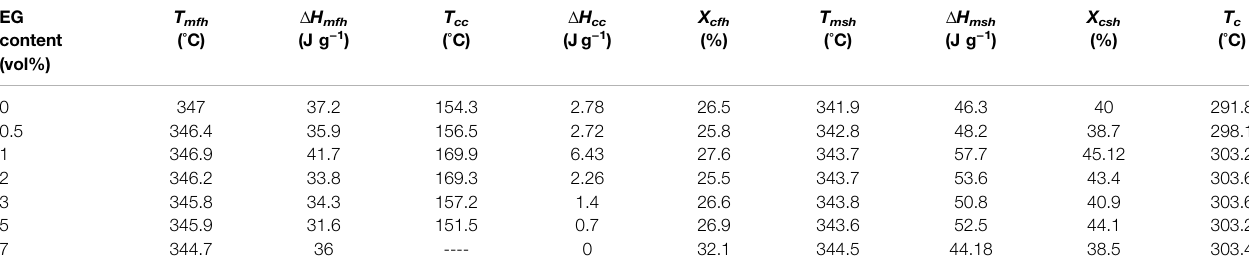
TABLE 1 | Non-isothermal crystallisation parameters of PEEK/EG composites obtained from the DSC measurements. EG content (vol%)